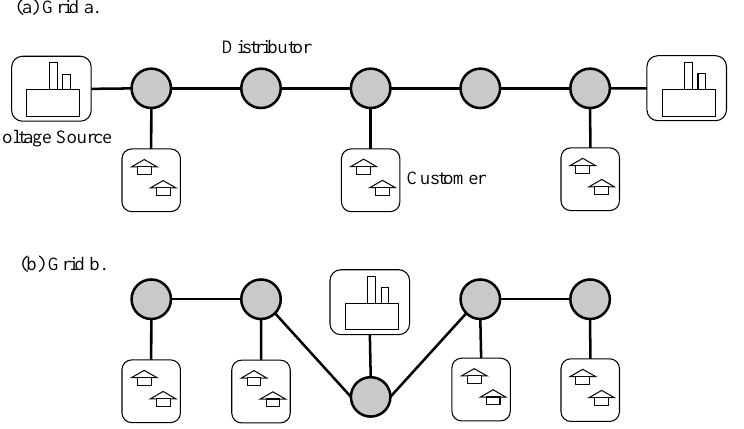
Figure 4. Power-grid environment. The grey circles are distributors, and their role is to distribute the voltage from the voltage source to the customer nodes.